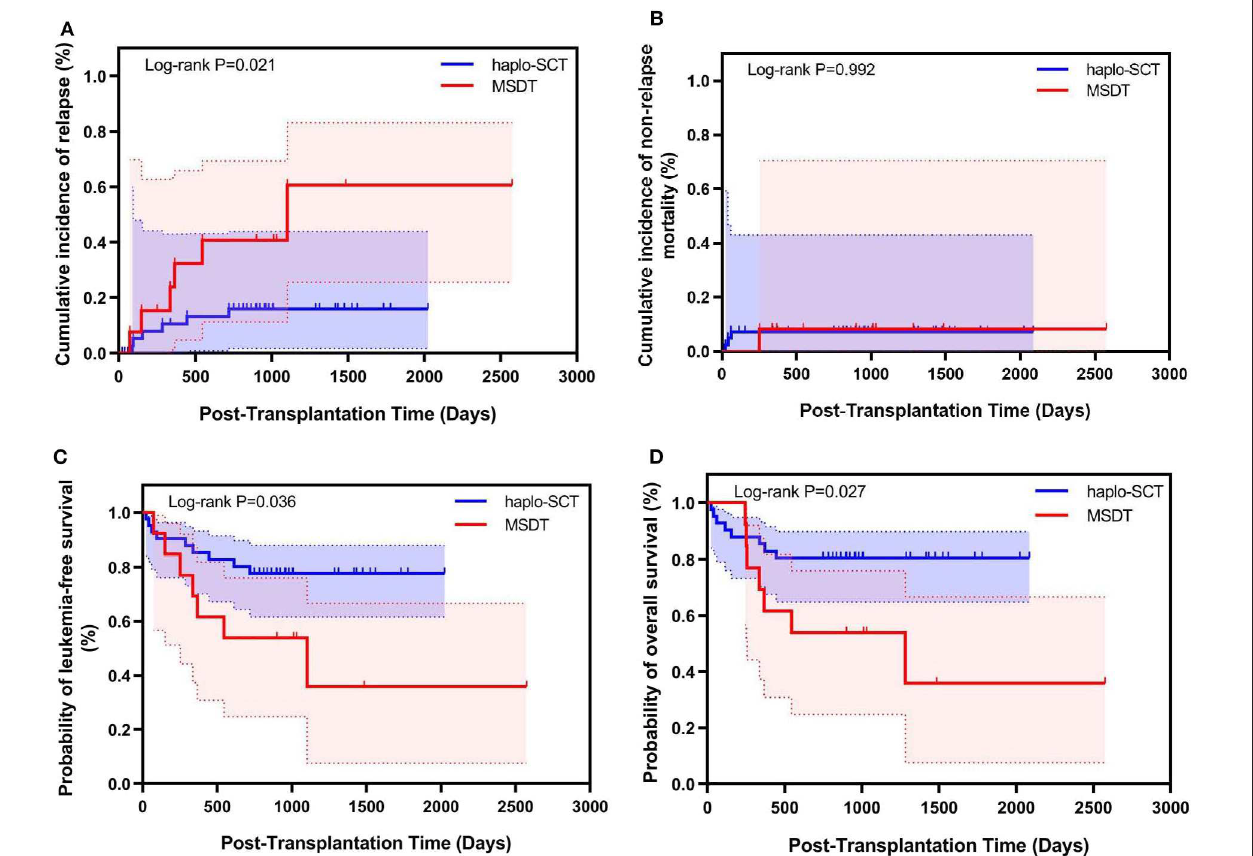
cases underwent haplo-SCT had a lower 4-year CIR compared Multivariate analysis showed that haplo-SCT was related to lower CIR (HR, 0.235; P = 0.077) ( Tables S1 , S2 ). We did not